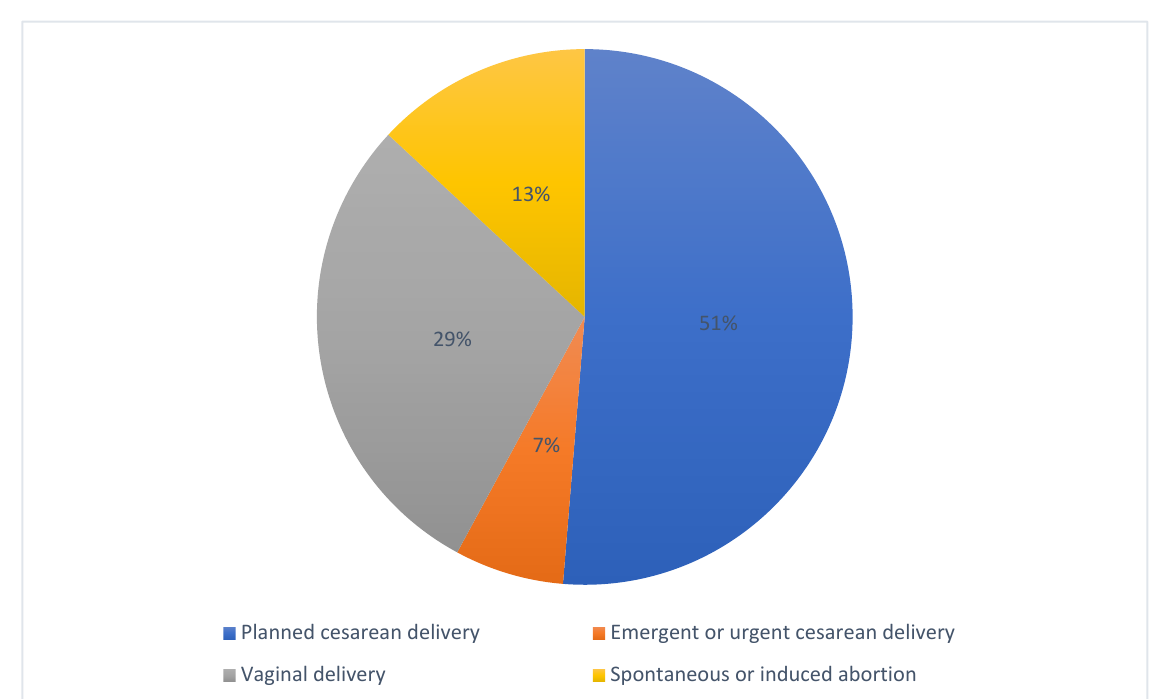
Figure 2. Characteristics of the included women.